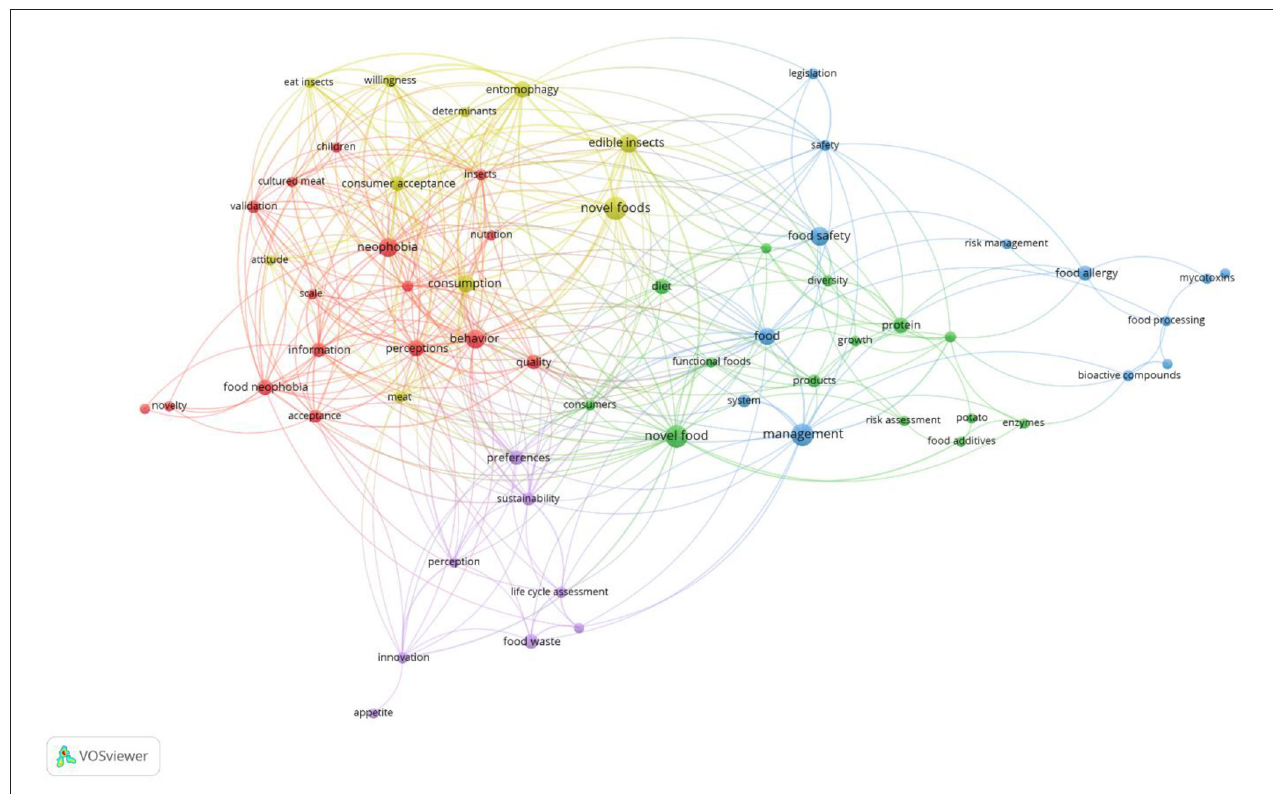
FIGURE 6 | Keyword co-occurrence map (Source: our elaboration).